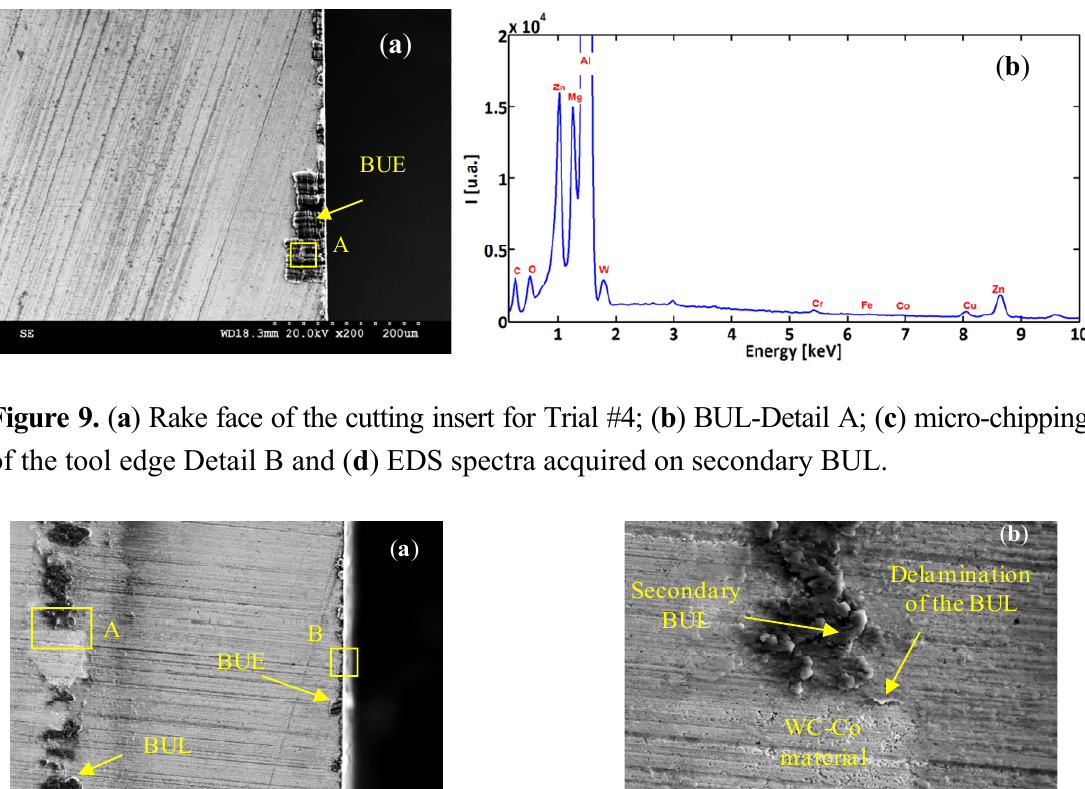
Figure 8. ( a ) Rake face of the cutting insert for Trial #2 and ( b ) EDS spectra acquired on BUE-Detail A.